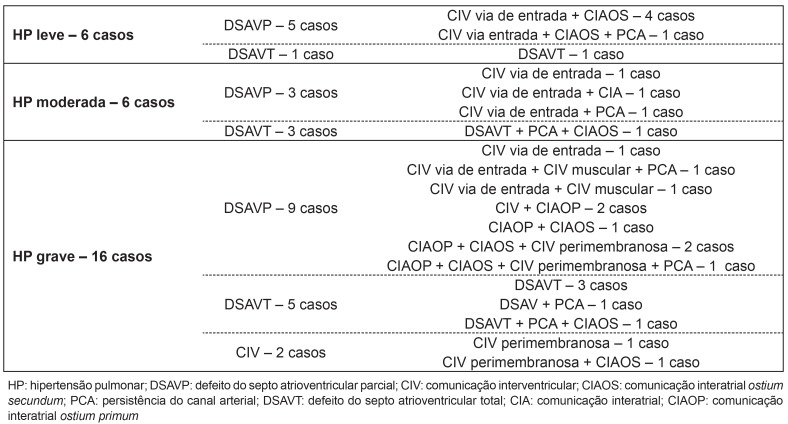
Relação entre grau de hipertensão pulmonar, quantidade de casos e
cardiopatias presentes